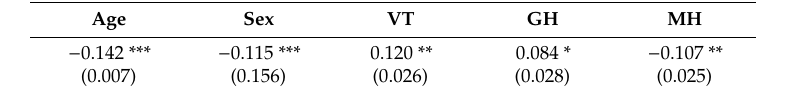
Table 6. Model 4. Dependent variable (power dimension of an entrepreneurial attitude). Independent variables: age, sex, level of studies, professional activity, and health. Age Sex VT GH MH − 0.142 *** (0.007) (0.156)